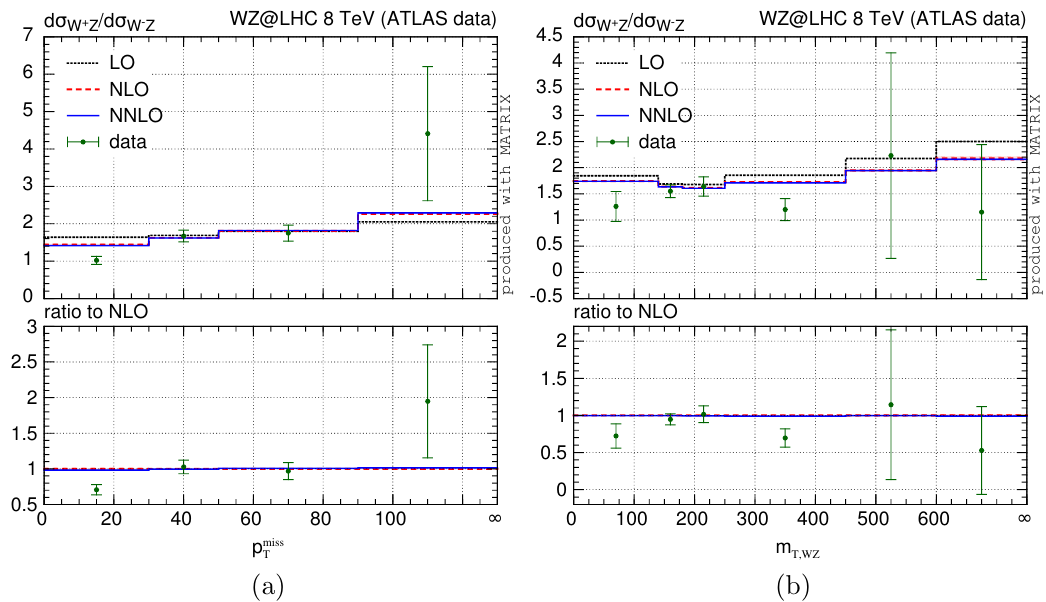
Figure 8 . Same as (cid:12)gure 4, but shows the ratio of cross sections for W + Z and W (cid:0) Z